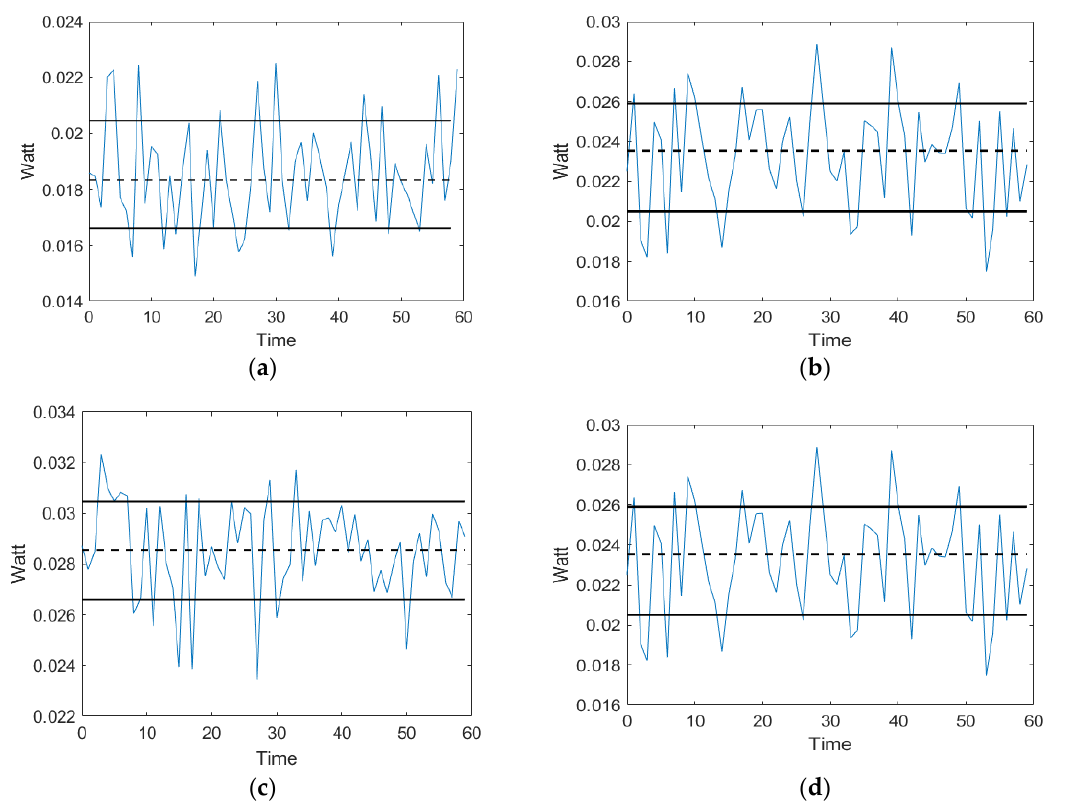
Figure 7. DCPower benefits of different cambers of the PZT protector.( a ) no protector, ( b ) low camber, ( c ) medium camber, ( d ) high camber. Table 3. Power benefits of di ff erent cambers of the PZT